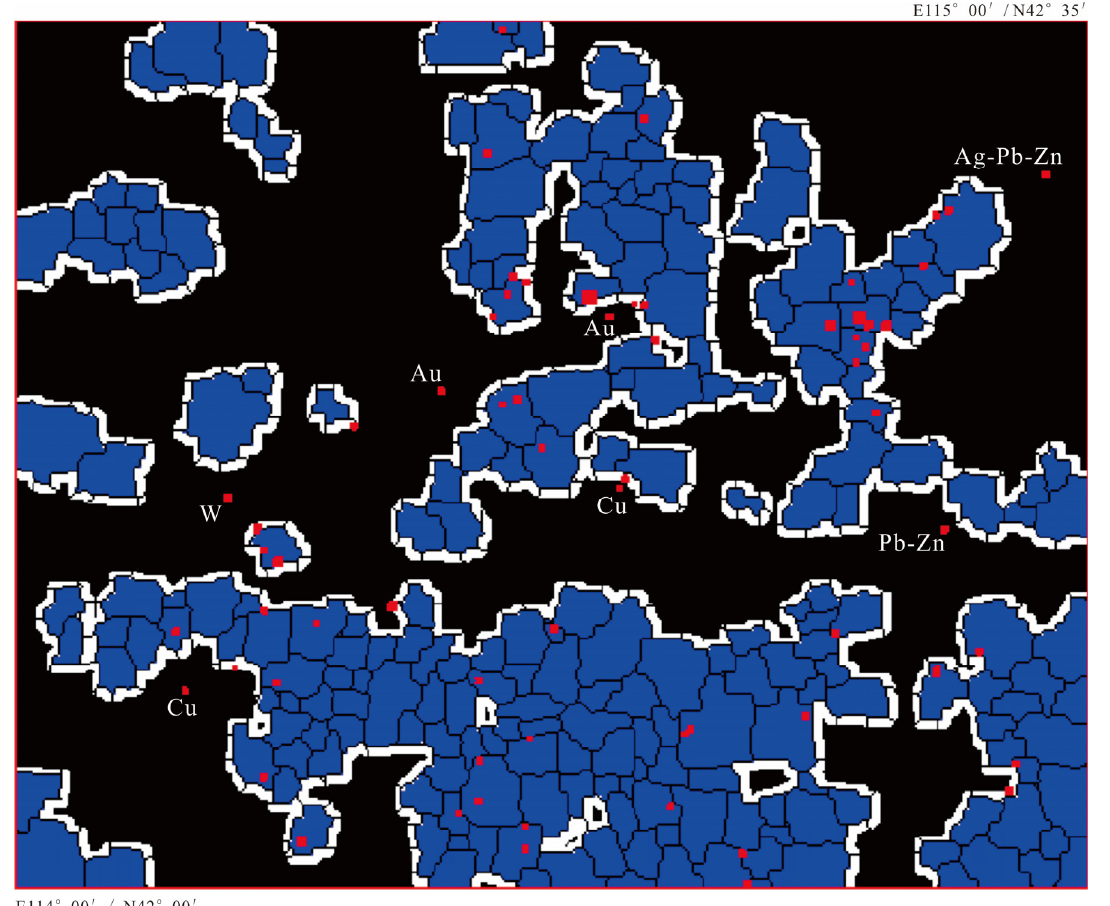
Figure 16. The buffered anomalous regions (blue colored patches edged with white) with all the known ore spots overlaid on it. Note that the anomalous regions are generated by using the 1:50,000 geochemical dataset consisting of 12 ore-forming elements (Ag, As, Au, Bi, Cu, Hg, Mo, Pb, Sb, Sn, W, and Zn) as input to OGE. We set the binarization threshold as the 60% quantile: 0.10515. Some ore spots, e.g., fluorite, Nb-Ta, etc., are removed from this figure because of the absence of relevant geochemical data. The 1:50,000 soil/stream-sediment geochemical data was provided by the Devel- opment Research Center, China Geological Survey. To ensure consistency, the 1:200,000 multireso- lution segmentation result shown in Figure 2 is reused to generate the 1:50,000 anomaly score map. Other legends in this figure are consistent with those in Figure 11 if not specified.